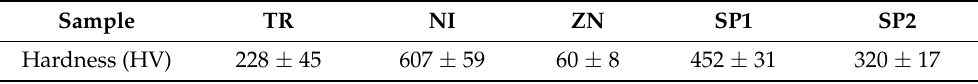
Table 4. Values of sub-superficial Vickers hardness of the studied surfaces (HV).